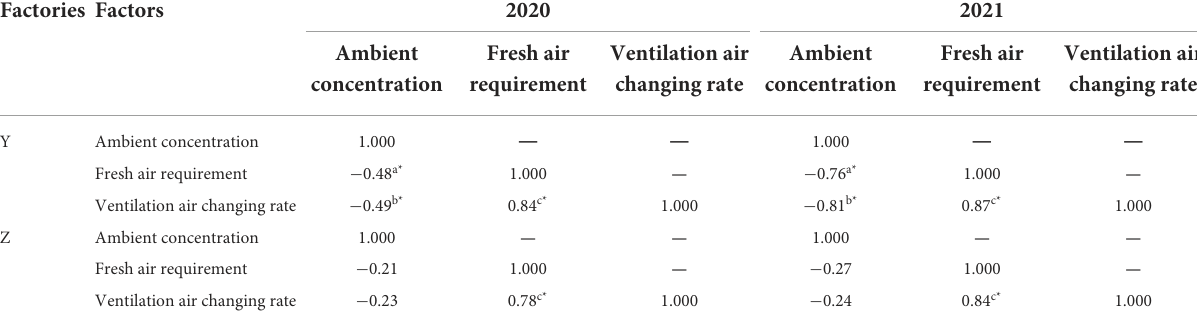
TABLE 5 Correlation analysis among ambient concentration, fresh air requirement, and ventilation air changing rate in Y and Z. Factories